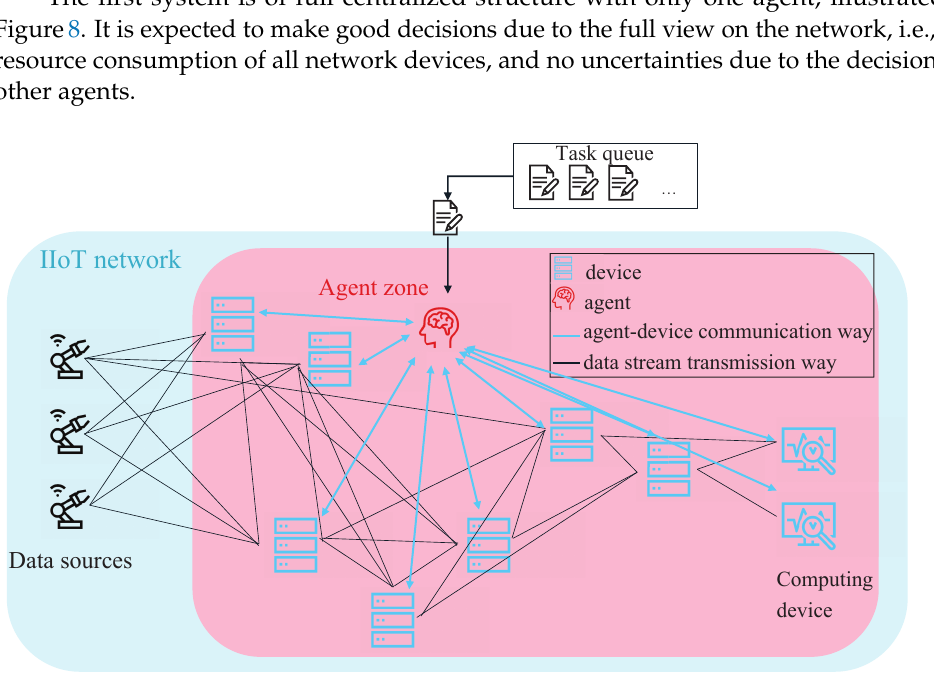
Figure 8. Schematic view on the architecture of the single-agent approach. The single agent has full view on the network and can communicate with all computing units. The agent receives the current CPU usage of the devices as states and either chooses a computing unit for task execution or no execution of the task. No execution would lead to appending the task again at the end of the task